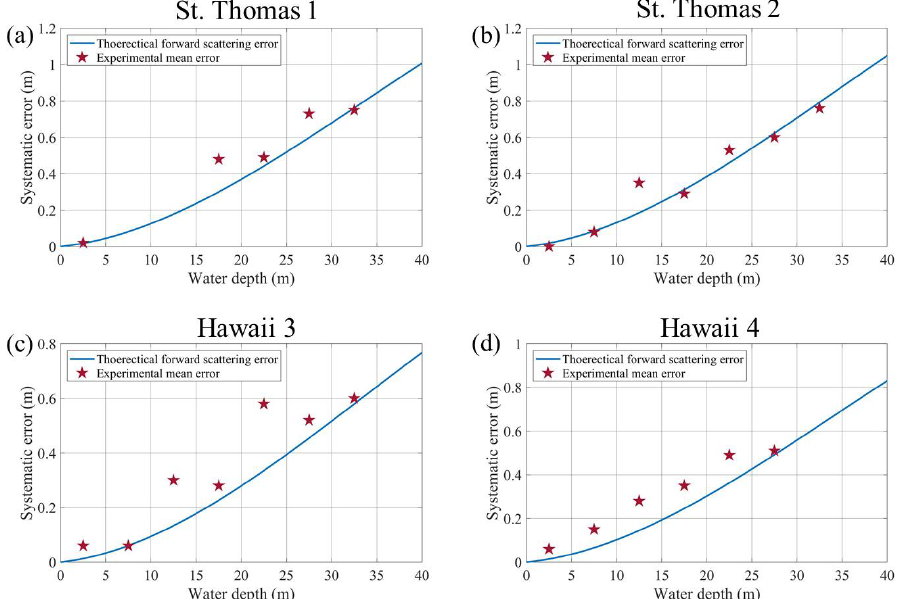
Figure 11. Relationship between water scattering-induced biases and water depths of four tracks. Blue curves are estimated by intrinsic optical parameters of local water and the empirical formula for ICESat-2, and red asterisks are the experimental mean errors in Tables 3 and 4. ( a , b ) correspond to St. Thomas, whereas ( c , d ) correspond to Hawaii.